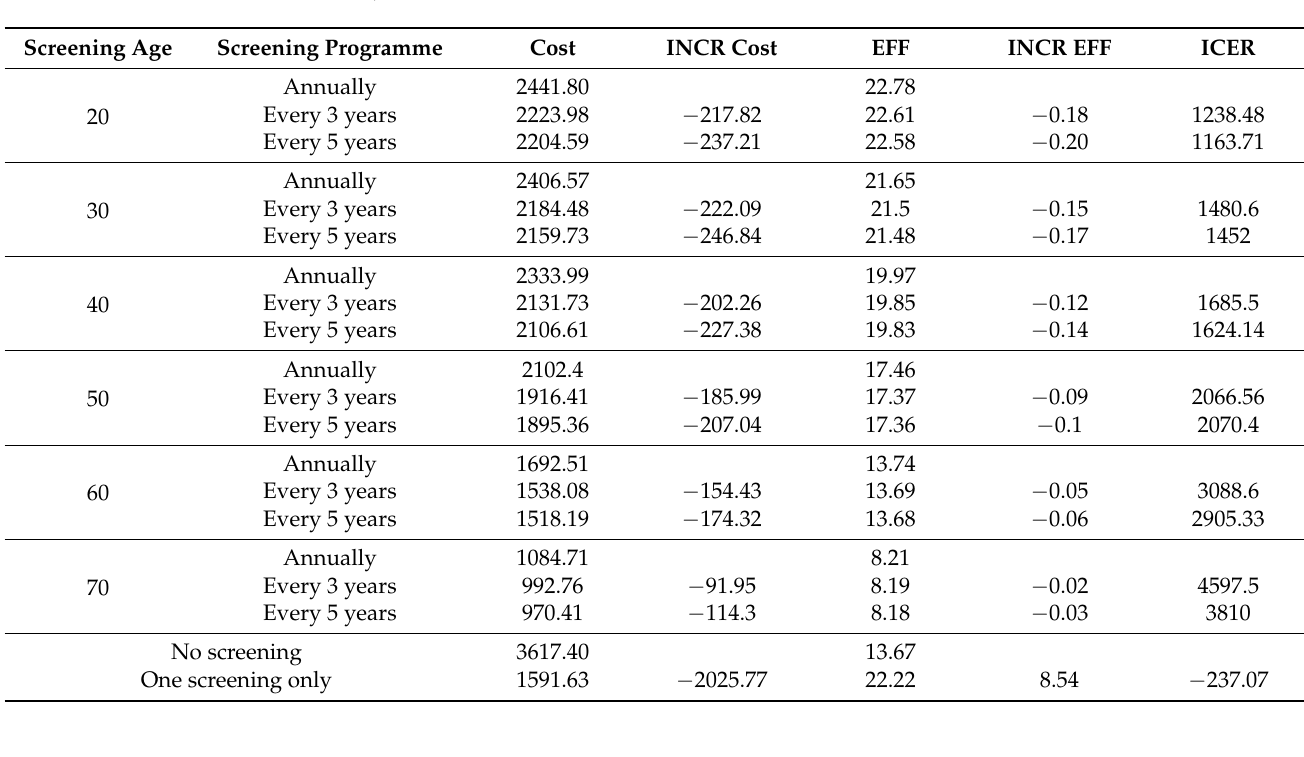
Table 4. The result of scenario sensitivity analyses. QALY, quality-adjusted life-year; EFF: effective- ness; ICER: incremental cost-effectiveness ration.